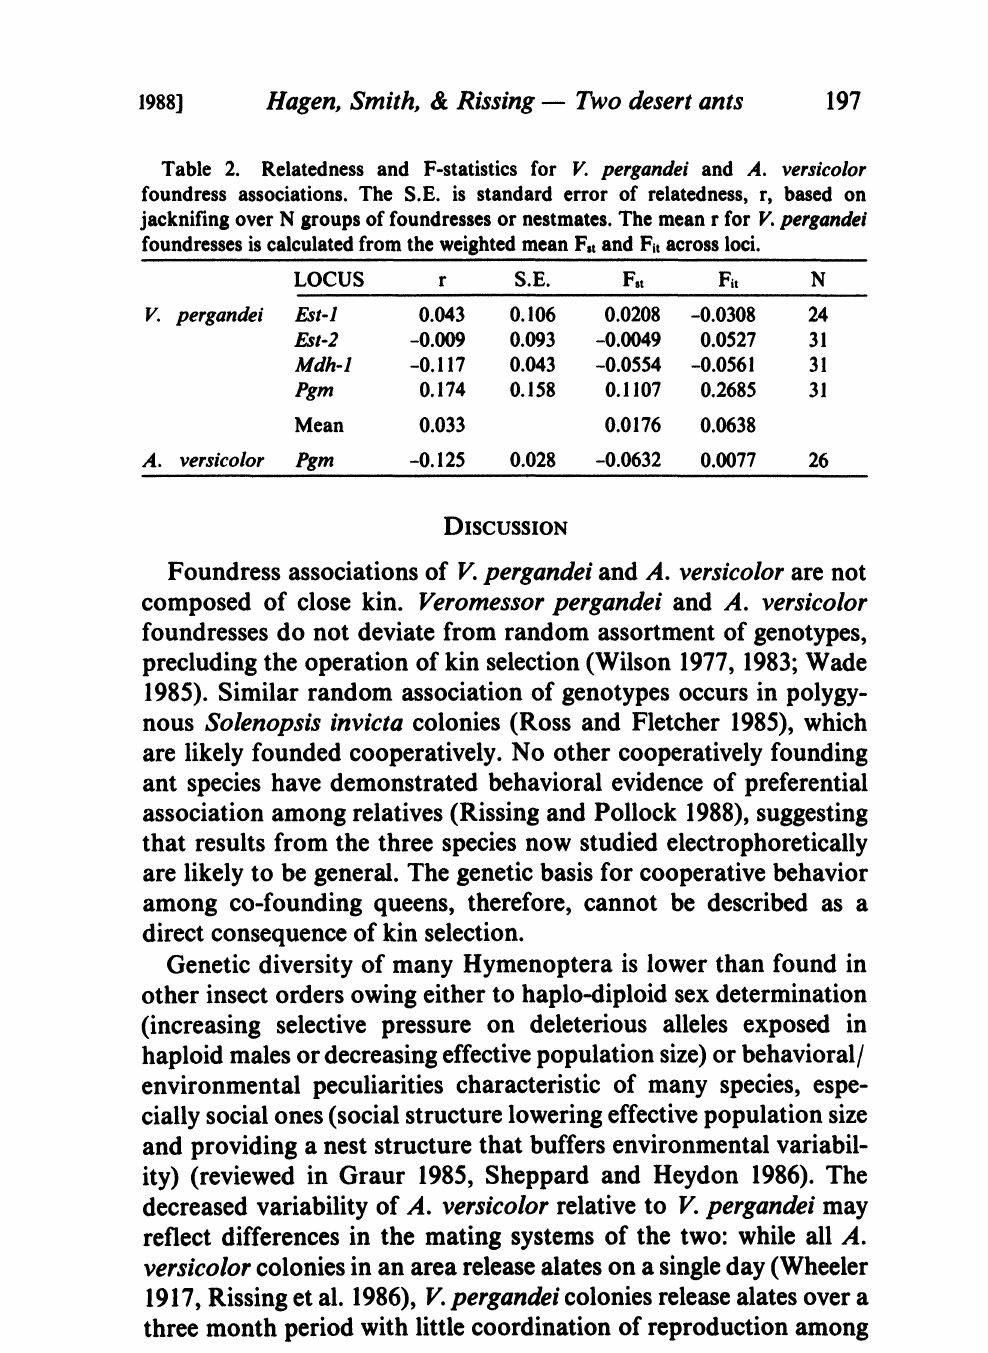
Table 2. Relatedness and F-statistics for V. pergandei and A. versicolor foundress associations. The S.E. is standard error of relatedness, r, based on jacknifing over N groups of foundresses or nestmates. The mean r for V. pergandei foundresses is calculated from the weighted mean F,t and Fit across